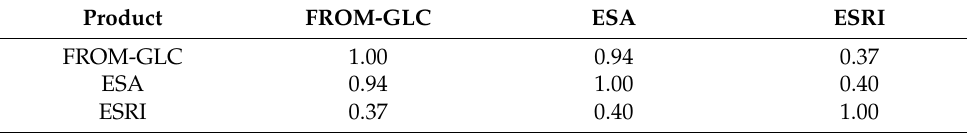
Figure 6. Area comparisons of different products. Table 4. The area composition Pearson correlation coefficients between different